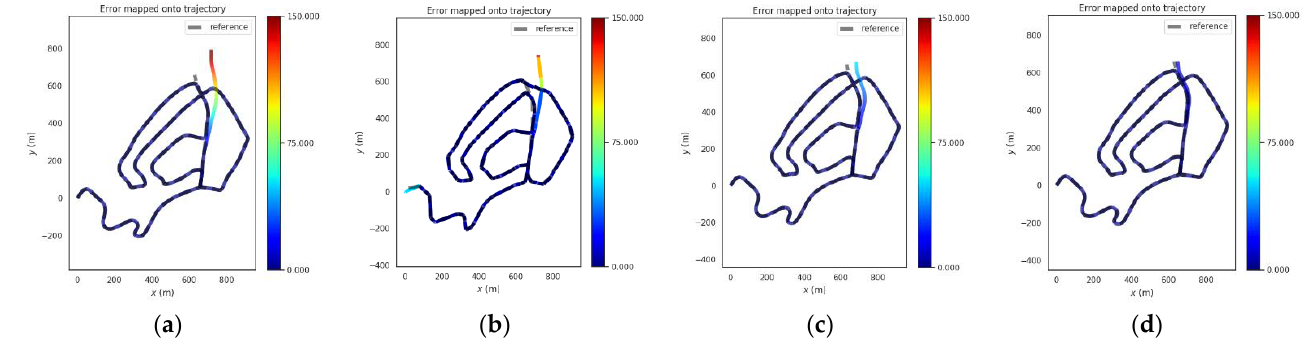
Figure 15. Trajectories of the four methods in rural scene. ( a ) GNSS, ( b ) VINS-Fusion, ( c ) PTC-SLM- Forward, ( d ) PTC-SLM. Table 7. Error parameters of the four methods in rural scene.